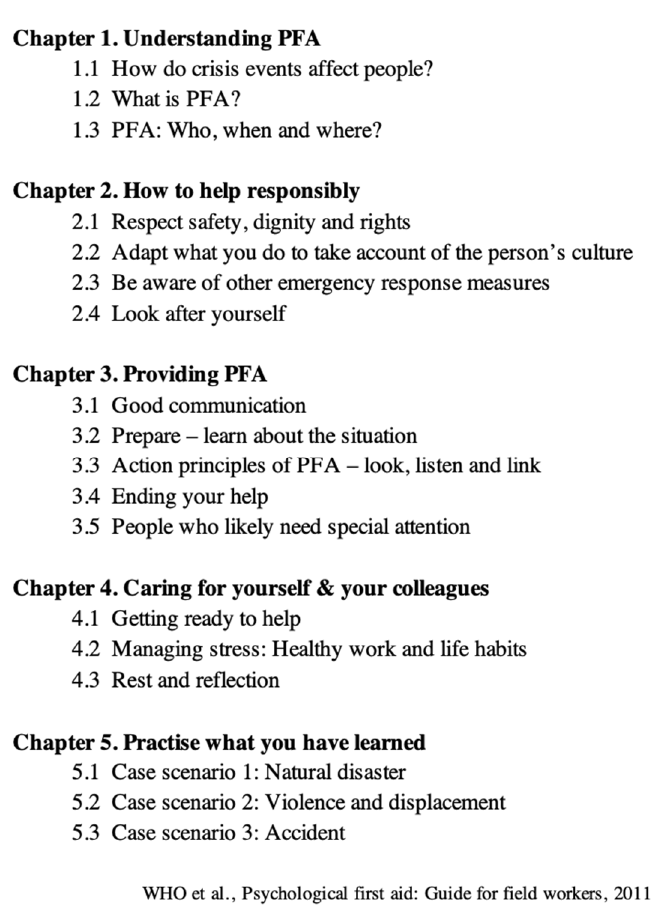
Figure 1. Psychological first aid: Guide for field workers table of contents